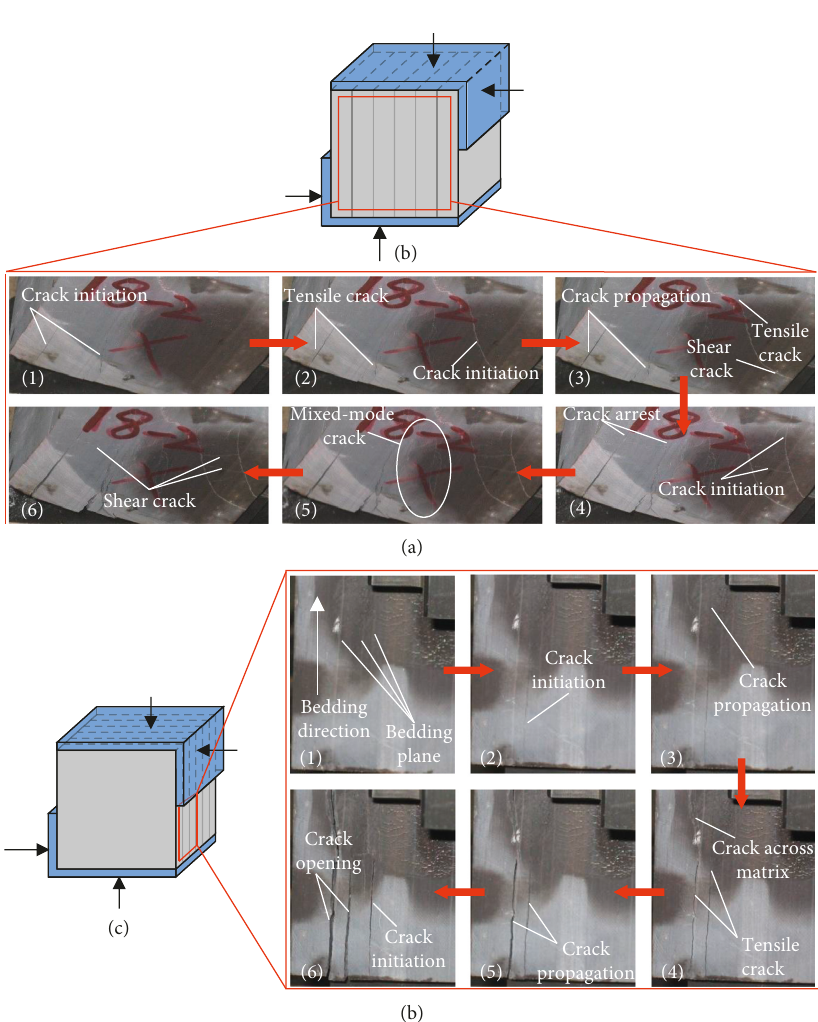
Figure 10: Failure evolution of loading modes: (b) and (c). (a). Failure evolution of condition b. (b). Failure evolution of condition